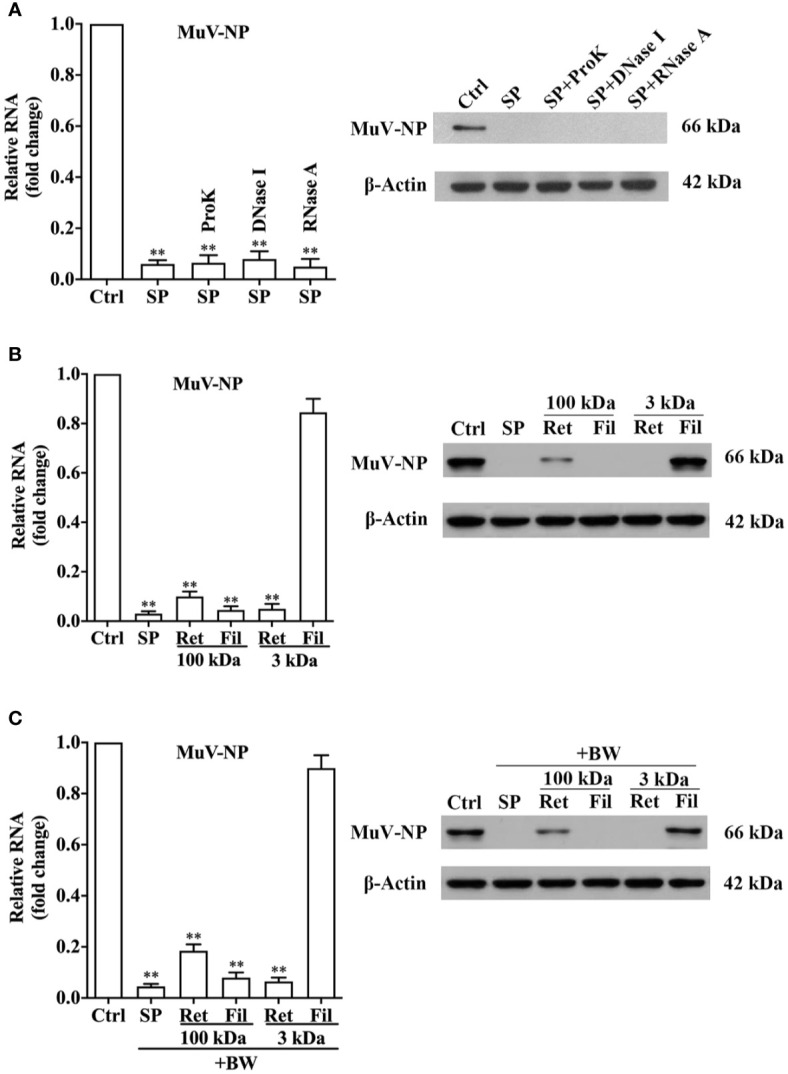
Characterization of antiviral component. (A) Physical properties of the antiviral component. SP was treated with proteinase K (ProK), DNase I, or RNase A at 37°C for 5 h. MuV was incubated with SP for 2 h, and MuV without treatment served as the control (Ctrl). HeLa cells were infected with 1.0 MOI of MuV. At 48 h post-infection, MuV-NP RNA (left panel) and protein (right panel) levels were determined using real-time qRT-PCR and a Western blot, respectively. (B) Size analysis of the antiviral component. SP was filtered through 100 kDa and 3 kDa filters. Filtrate (Fil) and retentate (Ret) fractions were collected. MuV was incubated with fractions for 2 h, and HeLa cells were infected with MuV. MuV-NP RNA (left panel) and protein (right panel) levels were determined. (C) Heat resistance of the antiviral component. The Fil and Ret fractions of ultrafiltration were treated with boiling water (BW) for 10 min, and then incubated with MuV for 2 h. MuV-NP RNA (left) and protein (right) levels were determined. Images represent at least three independent experiments. Data are presented as means ± SEM of three experiments, **P < 0.01.